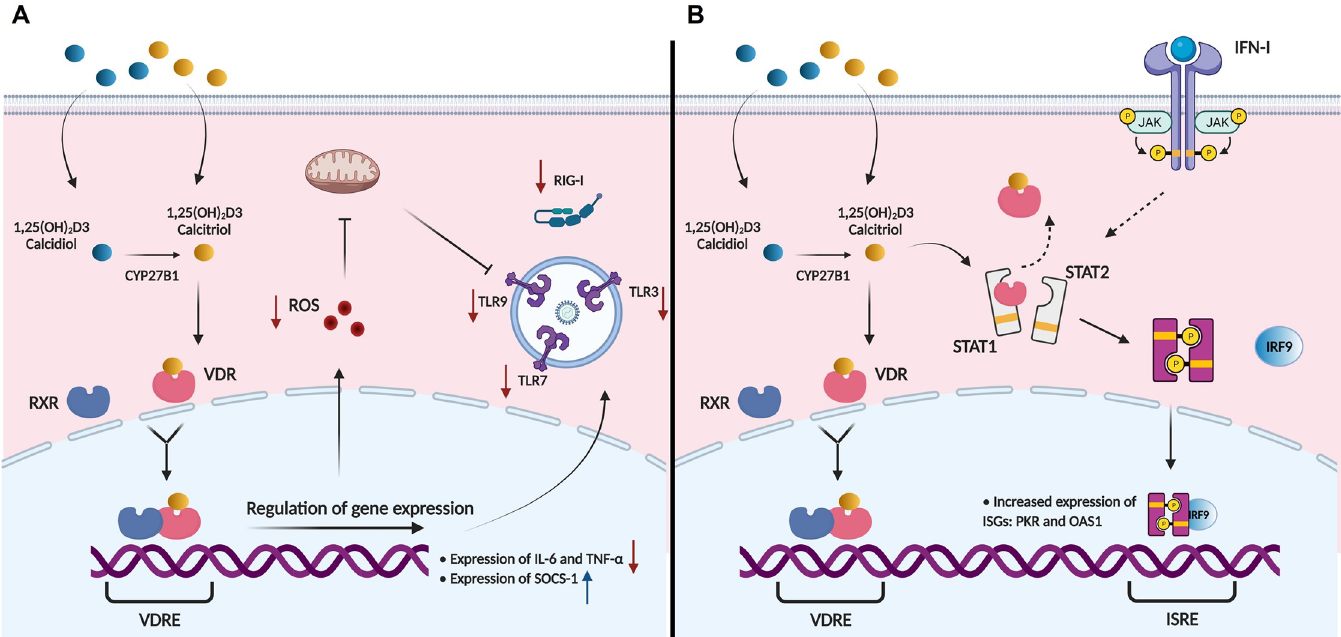
Fig 7. Hypothetical model of VitD3 effects in D 3 -MDMs during DENV-2 infection. (A) VitD3 can be found as inactive form 25(OH) 2 D2 (calcidiol), as active form 1,25 (OH) 2 D3 (calcitriol), or be converted from inactive to active form within the cell by the action of CYP7B1. VitD3 interacts with the vitamin D receptor (VDR) present in the nuclei and associates then, with the nuclear receptor retinoid X receptor (RXR). Together, they act as transcription factors that will increase the expression of genes that have vitamin D response elements (VDRE) [58,59].Genomic effects of VitD3 during DENV-2 infection include decreased expression of IL-6, TNF- α , RIG-I, TLR3, TLR7 and decreased production of reactive oxygen species (ROS). Since ROS can induce mitochondrial damage and then increase activation and expression of TLR9 [28], VitD3 reduced TLR9 expression indirectly. (B) As a non-genomic effect, VitD3 can bind to VDR that is initially bound to STAT1 [29], and indirectly enhance the activity of the JAK-STAT signaling pathway and IFN-I activity, thus increasing expression of PKR and OAS1.